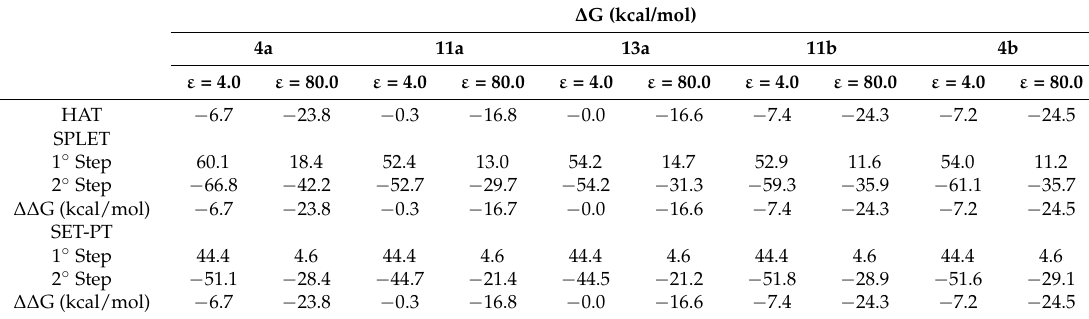
Table 2. Gibbs free energies values ( ∆ G) for all reactions between Vam3 most stable derived species with · OOH free radical target involved in HAT, SET-PT and SPLET mechanisms. ∆ G